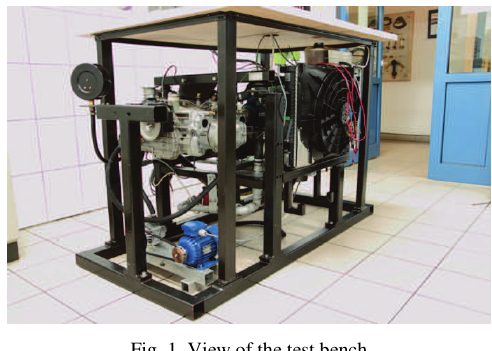
Fig. 1. View of the test bench The changes made during each revolution of the crank- shaft forces the repeating cycle of compression and